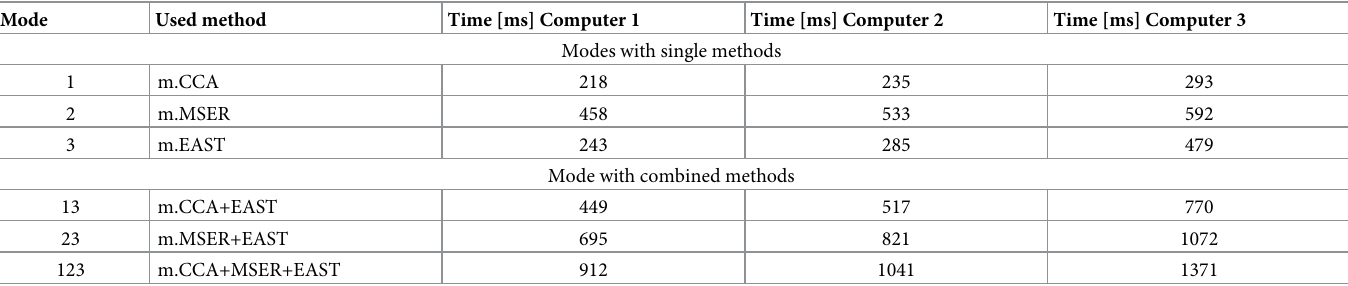
Table 2. Average vessel identification speed for comparative dataset